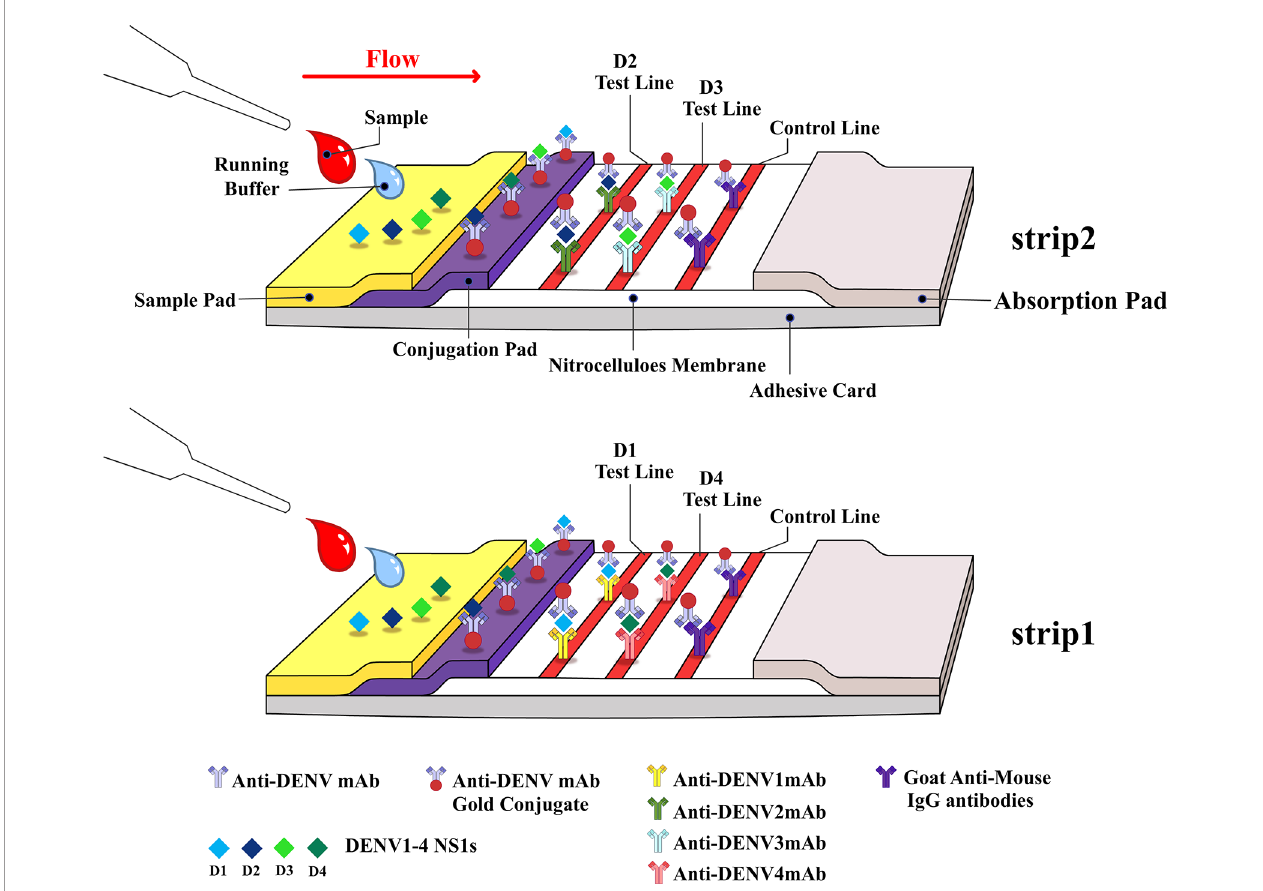
FIGURE 1 | Schematic illustration showing Dengue serotype NS1 multiplex LFIA, comprising the following elements: Sample conjugation pad, membrane with immobilized antibodies, and absorption